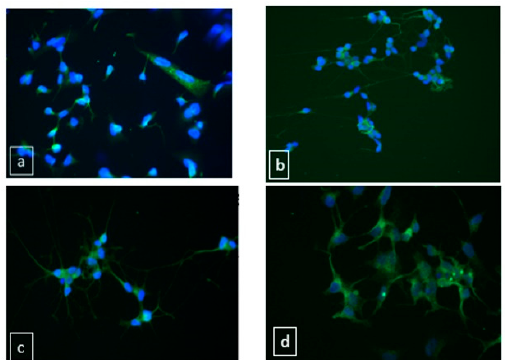
Figure 2. MAP-2 expression in differentiated and undifferentiated SH-SY5Y cells. ( a ) undifferentiated cells ( b ) pre-treated RA followed with BDNF ( c ) pre-treated RA followed with Mix medium ( d ) pre- treated RA followed with Mix medium and BDNF.